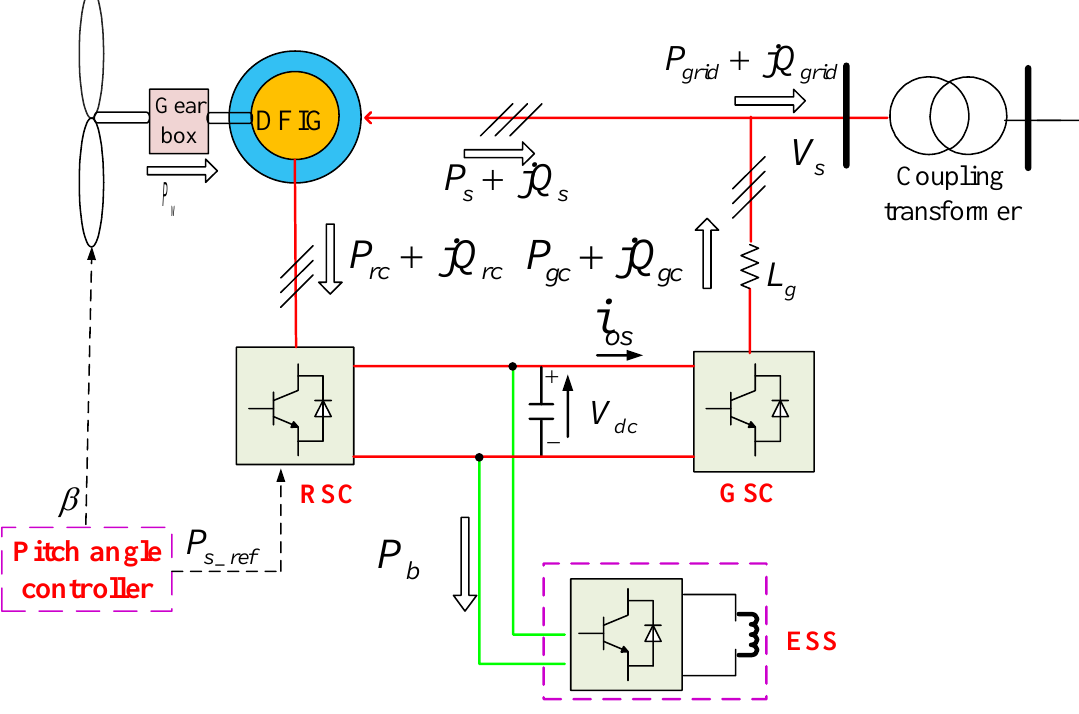
Figure 1. Structure of the doubly-fed induction generator (DFIG)-energy storage system